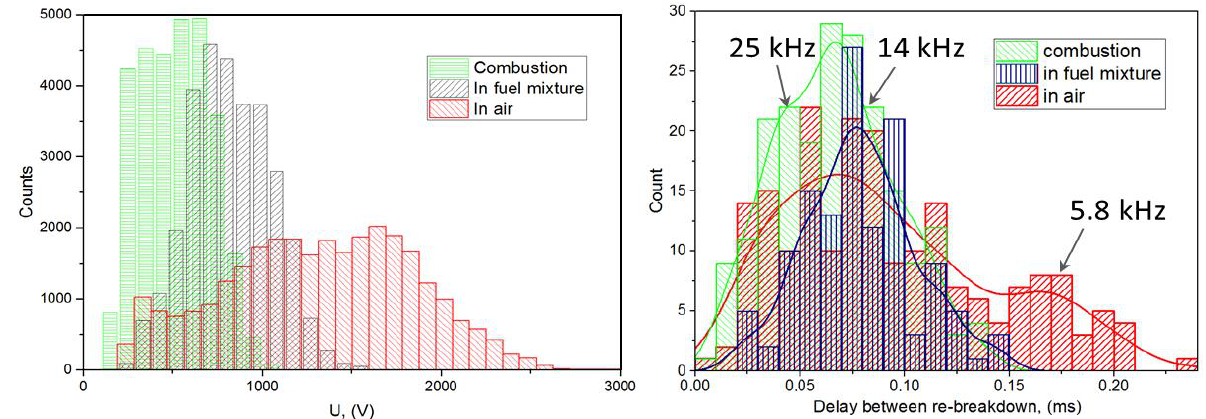
Figure 7. Statistical data about discharge voltage and re-breakdown period for ver.b configuration.